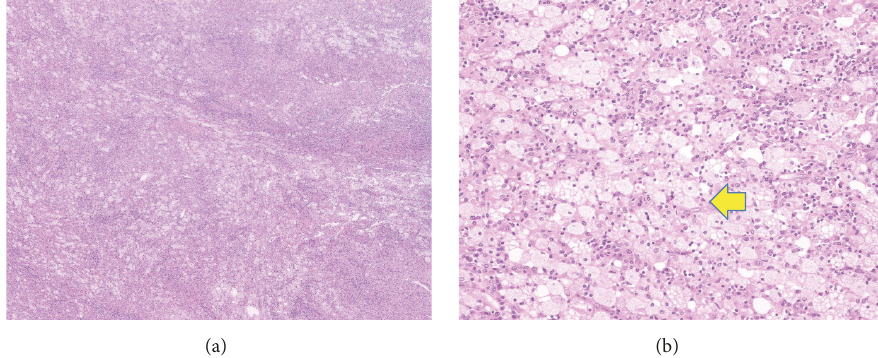
Figure 4: Infiltration of inflammatory cells including foam cells, plasma cells, and lymphocytes ((a) × 40). There is aggregation of foam cells (arrow) ((b) × 400) in hematoxylin and eosin